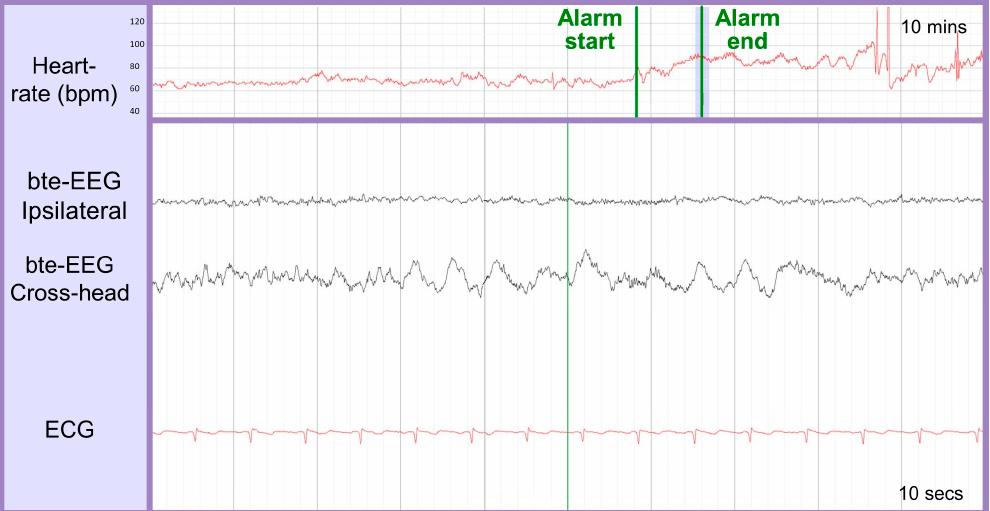
Figure 8. Example of a detected segment incorrectly labeled as a seizure by the algorithm and by the readers on both the bte-EEG setup and the bte-EEG and ECG and heart rate setups(FP). The top plot contains the heart rate data in red within a 10 min window, and the bo tt om contains the bte-EEG channels (in black) and ECG data (in red) within a 10 s window. The shaded section of the heart rate plot corresponds to the plo tt ed area of the bo tt om one. The green vertical lines indicate the automated algorithm’s time events.